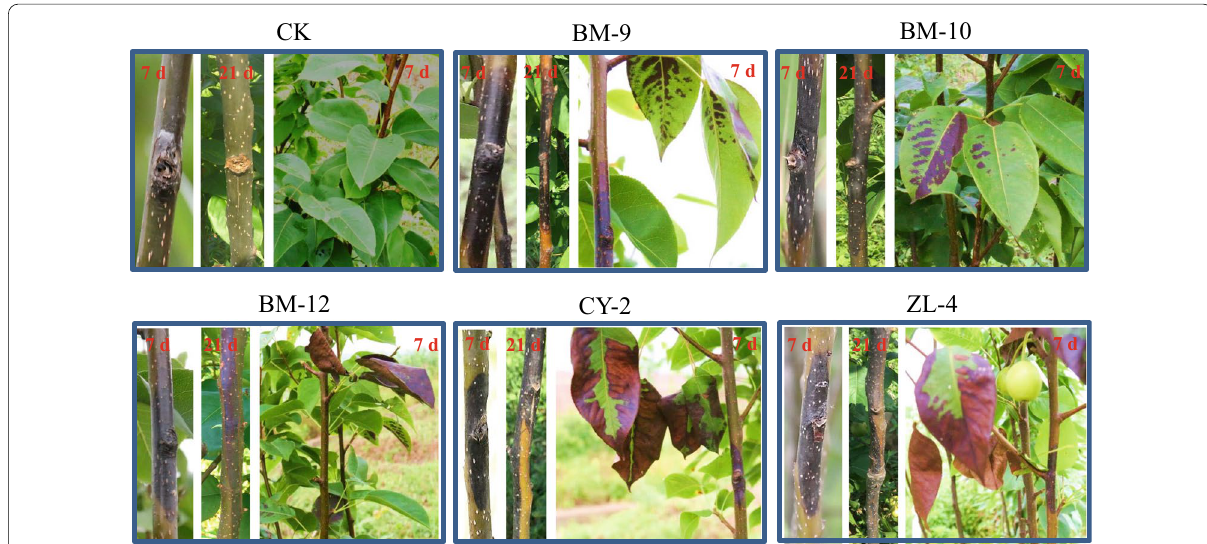
Fig. 4 Pathogenicity of five N. parvum isolates on pear trees in the field. The PDA plugs with N. parvum mycelia were placed on the wounded pear branches, using PDA plugs without fungi as the control. The photos were taken at 7 and 21 days post-inoculation (dpi)